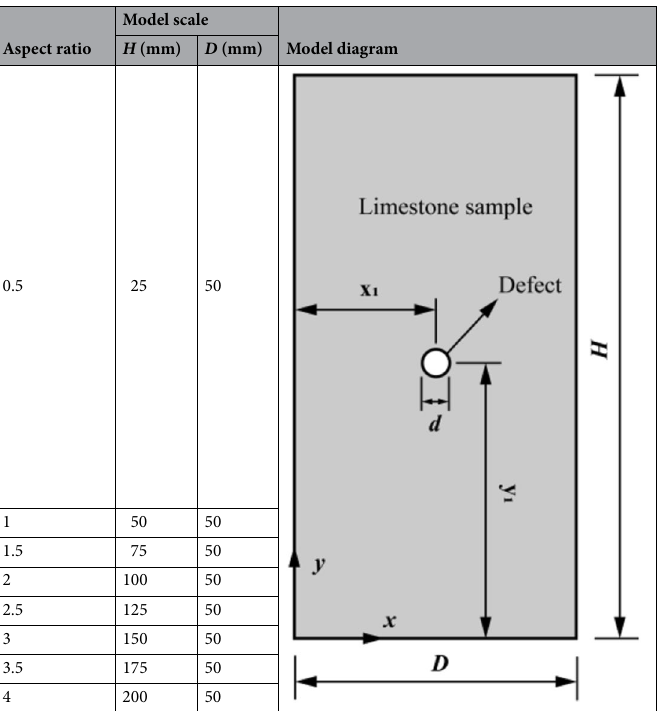
Table 3. Distribution of sample defects.